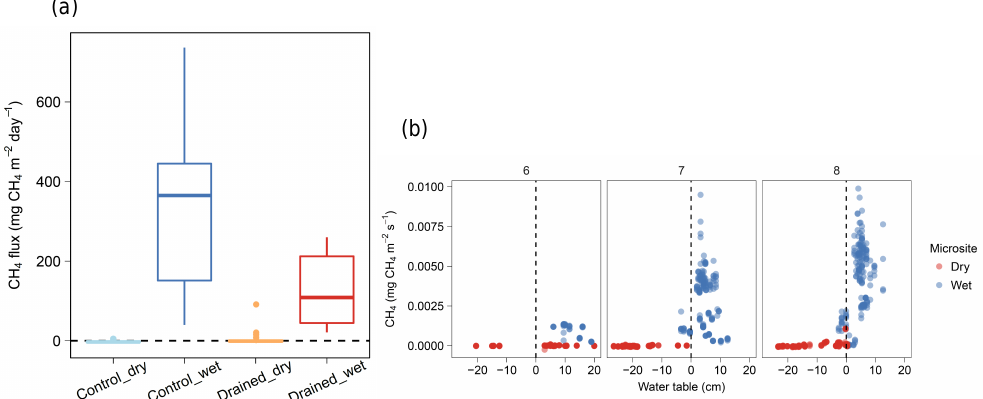
Figure A3. Daily methane flux rates (a) aggregated from flux chamber measurements within the growing season of 2014. Measurements are separated into drained (one wet microsite, nine dry microsites) and control (eight wet microsites, two dry microsites) transects; (b) flux rates against the water table at each microsite. Dry plots had a water table at or below the surface (up to 10cm), whereas wet plots had a water table at or above the